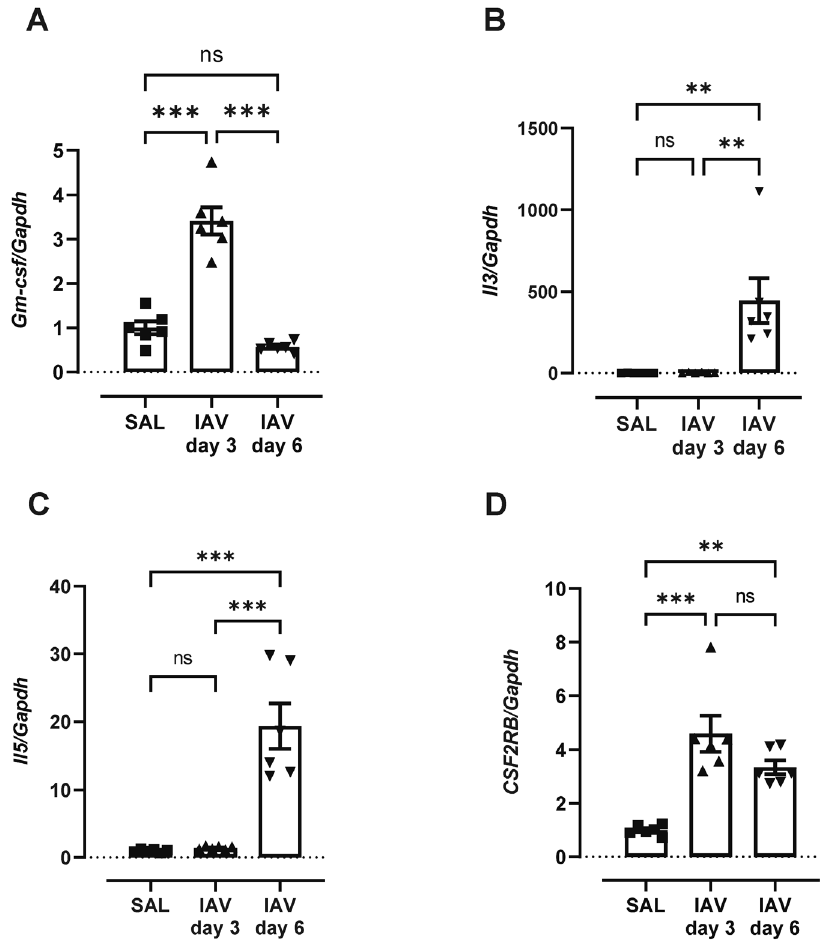
Fig. 5 β c cytokines and β c receptor are overexpressed in IAV infected h β c Tg mice. h β cTg mice were infected with IAV (10 4 PFU, HKx31 strain) and culled at day 3 and day 6 post infection. Gene expression for β c cytokine ( A ) Gm-csf , ( B ) Il3 , ( C ) Il5 and β c receptor ( D ) CSF2RB were analyzed in lung tissue by RTqPCR. n = 6; data are Mean ± SE; * p < 0.05, ** p < 0.01, *** p < 0.001 one-way